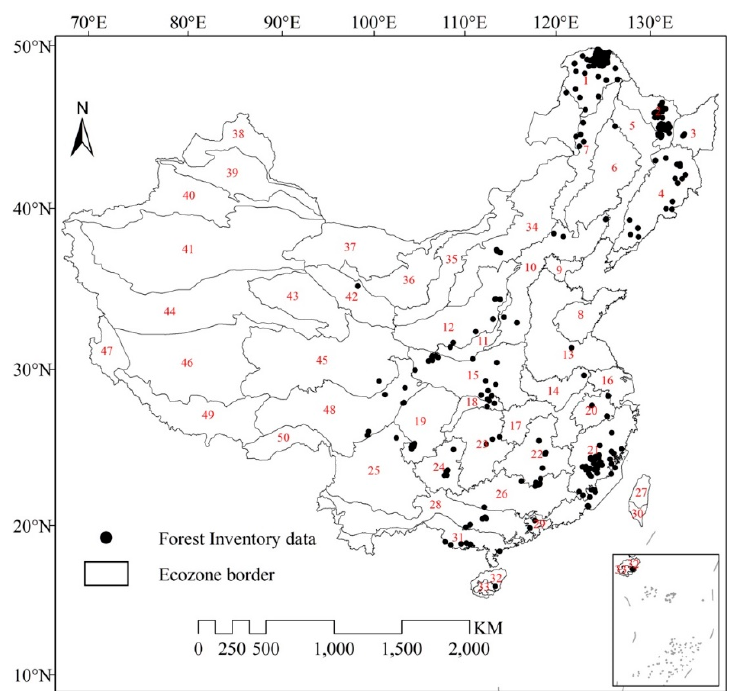
Figure 4. Geographic distribution of 525 forest plots. Red indicates the code of each ecozone; their corresponding information are listed in the supporting Table S1.